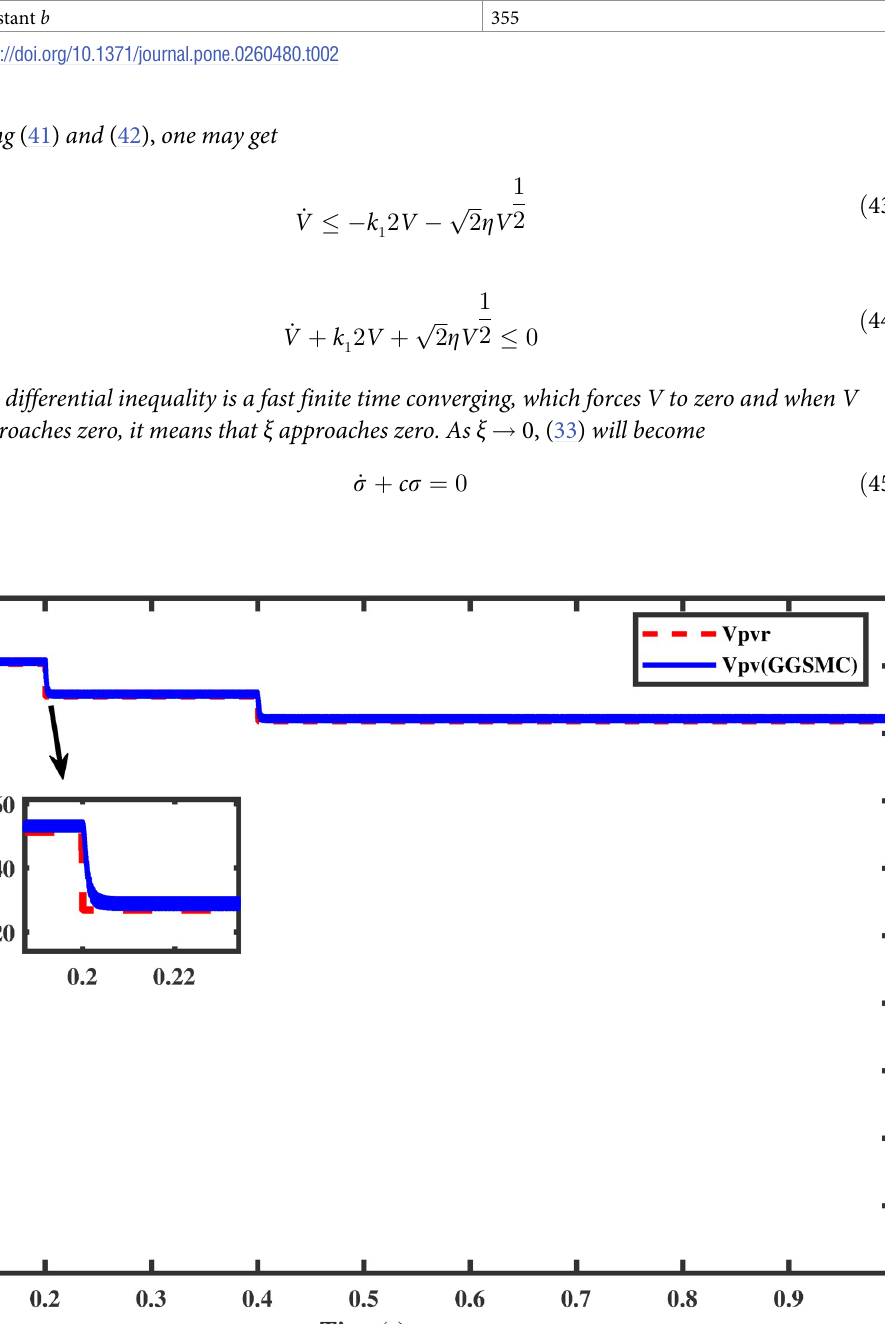
with respect to V pv